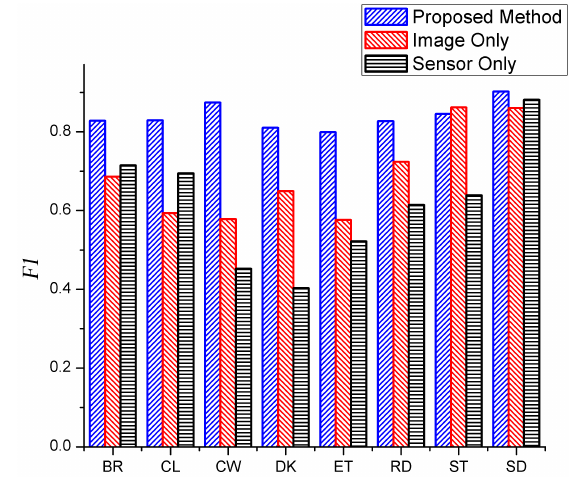
Figure 12. Comparison between the data fusion and single source data.